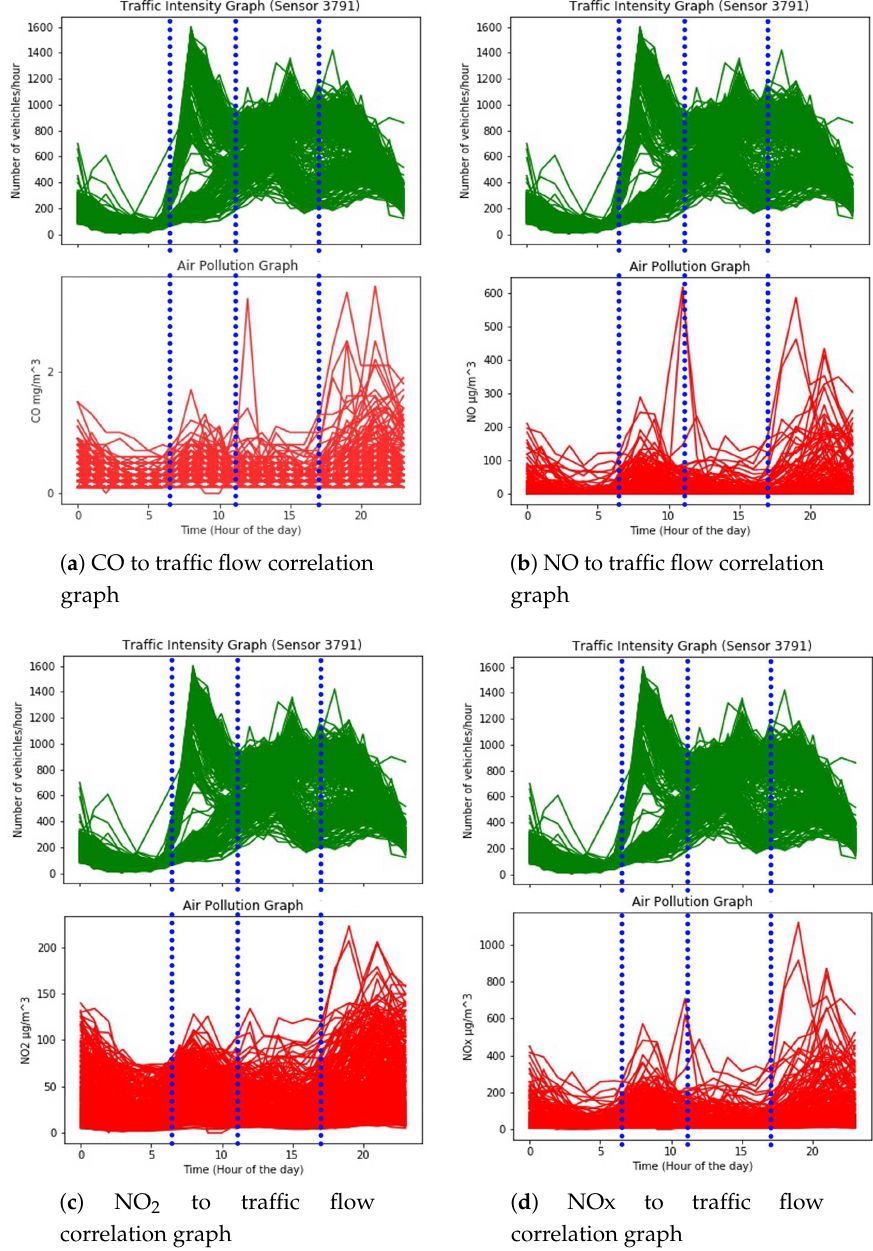
Figure 5. Correlation graphs of traffic flow and air pollutants with respect to each hour of the